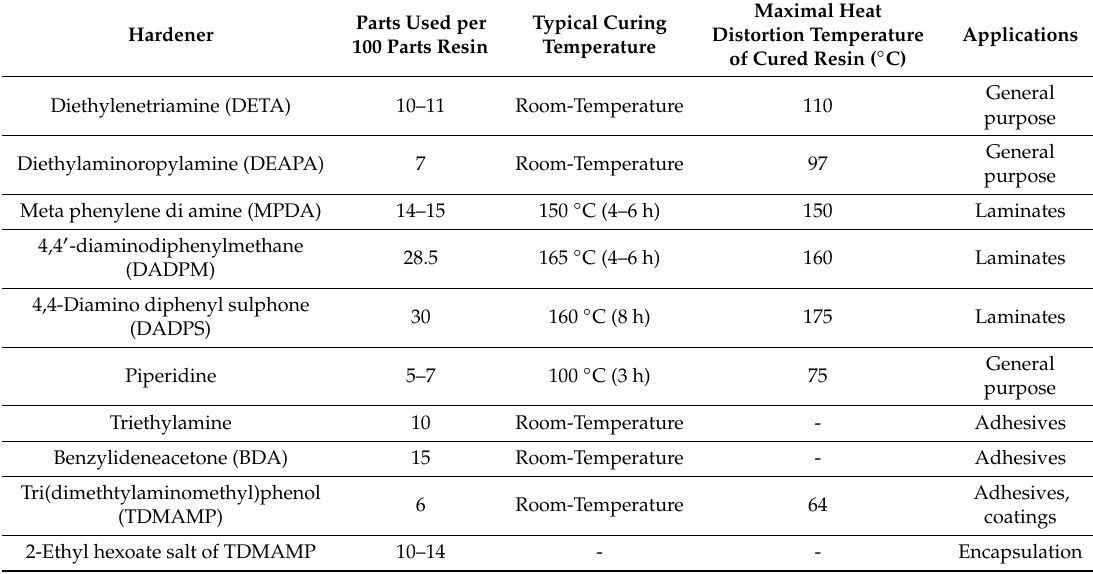
Table 2. Characteristics of amine hardeners used in low-molecular-weight bisphenol A-based epoxy resins, adapted from [3].